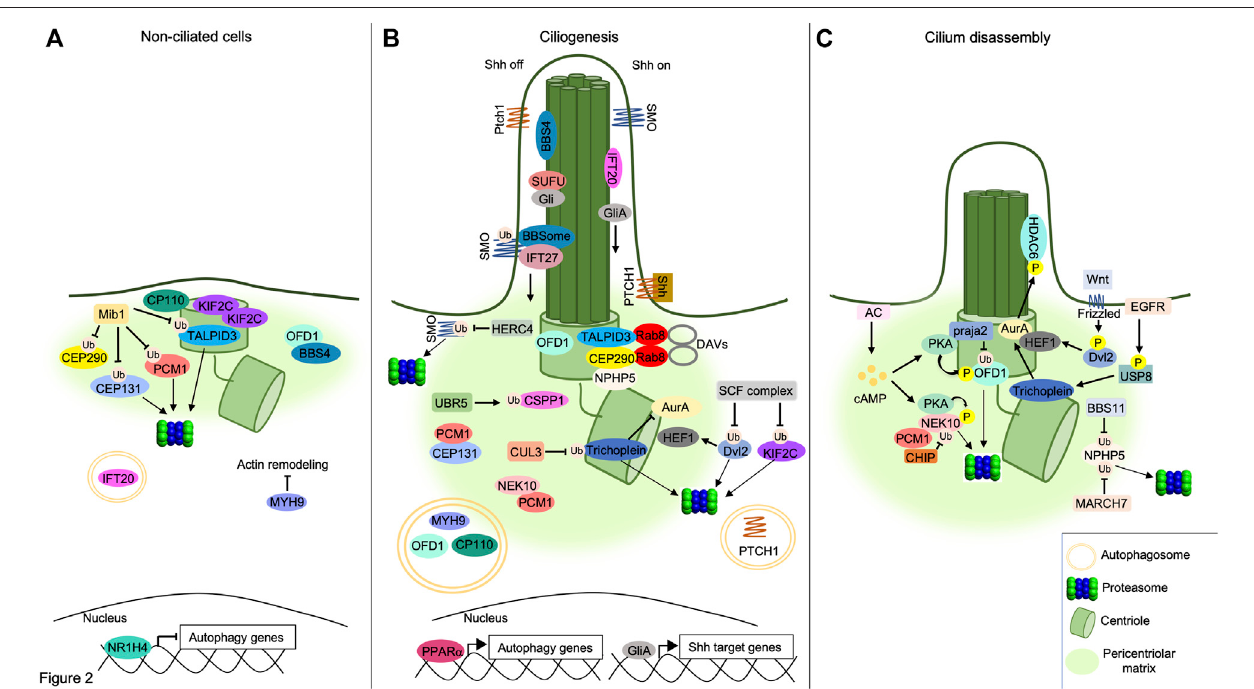
FIGURE 2 | Interplay between UPS/autophagy and signaling pathways in cilia dynamics. (A) UPS and autophagy inhibit ciliogenesis. The E3 ligase MIB1 ubiquitylates PCM1, TALPID3 and CEP131, targeting them to the proteasome, while ubiquitylation of CEP290 by MIB1 prevents its binding to TALPID3, inhibiting the formationofDAVs.OFD1 retainsBBS4at pericentriolarsatellitesand preventsBBSome assembly. Accumulation ofKIF2C andCP110 atbasalbody,inhibition ofacting remodeling by MYH9 and proteolysis ofIFT20 by autophagy prevent cilium elongation. The inhibition of autophagy genes by the nuclear factor NR1H4 is indicated below. (B) PositiveroleofUPSandautophagy inciliogenesis.Centrosomal TALPID3/CEP290/Rab8complexsupportsDAVsformation.UBR5ubiquitylatesandtargets